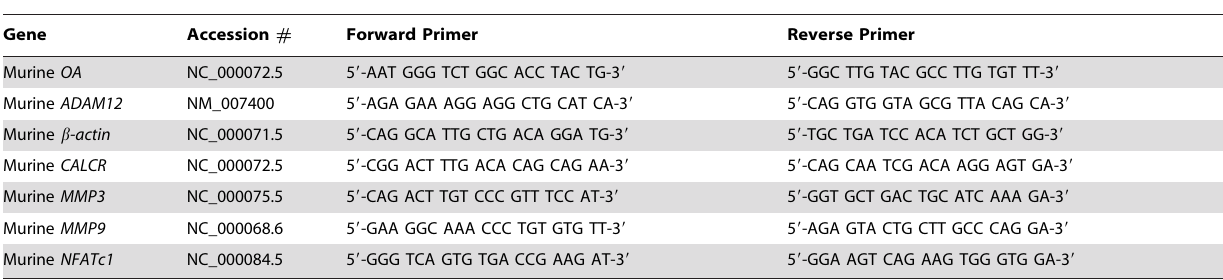
Table 6. Sequence of primers used in real-time